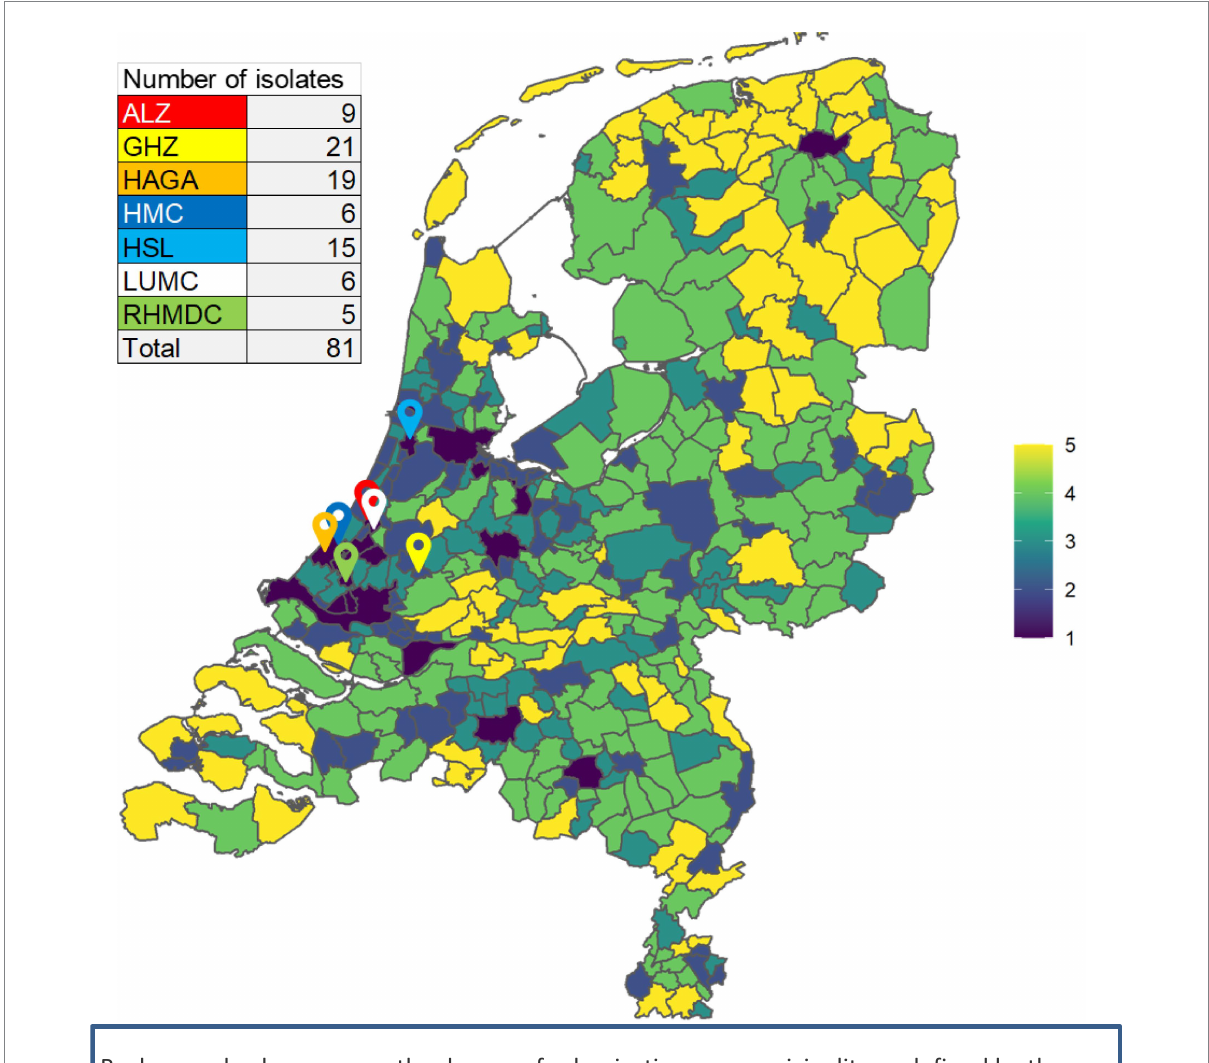
FIGURE 1 Map of Netherlands showing the urbanization level and the participating